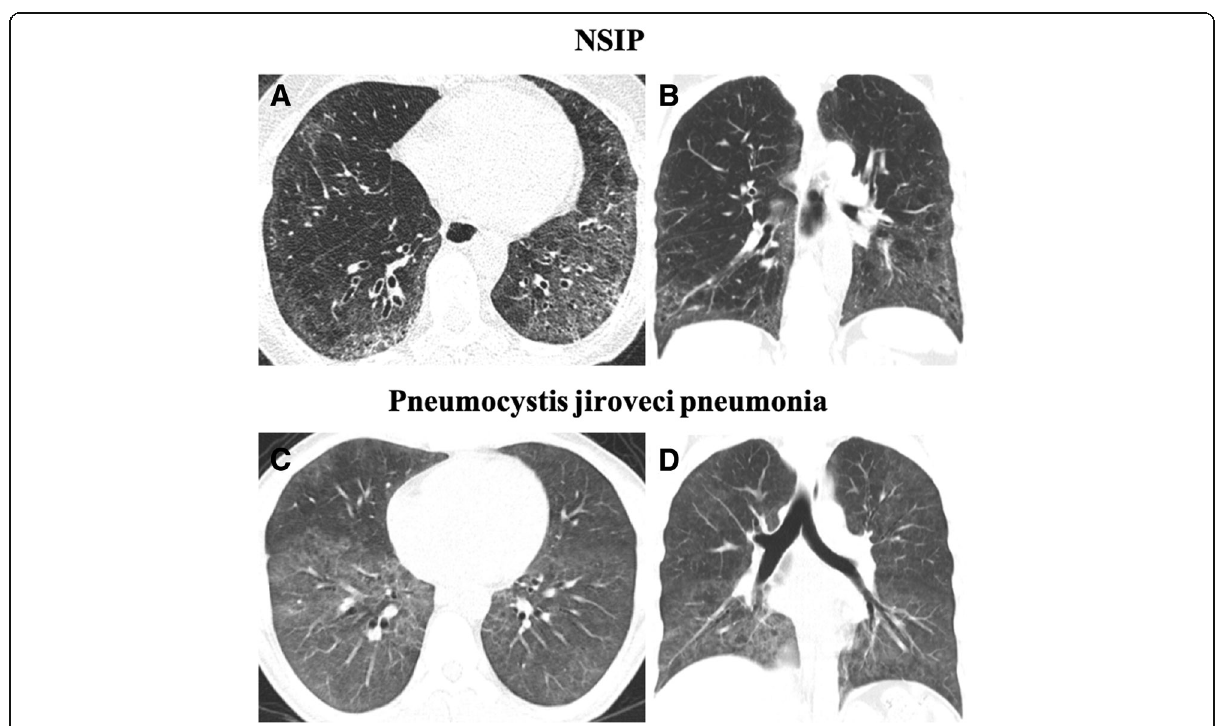
Fig. 18 Differential diagnosis of DIP. a Axial and b coronal CT images depict NSIP in a female patient with systemic sclerosis. CT findings show bilateral and asymmetrical ground-glass opacities, with a lower lobe predominance and immediate subpleural sparing. c Axial and d coronal CT images depict pneumocystosis in an immunocompromised patient with HIV. Imaging findings show bilateral ground-glass opacities, predominantly in the lower